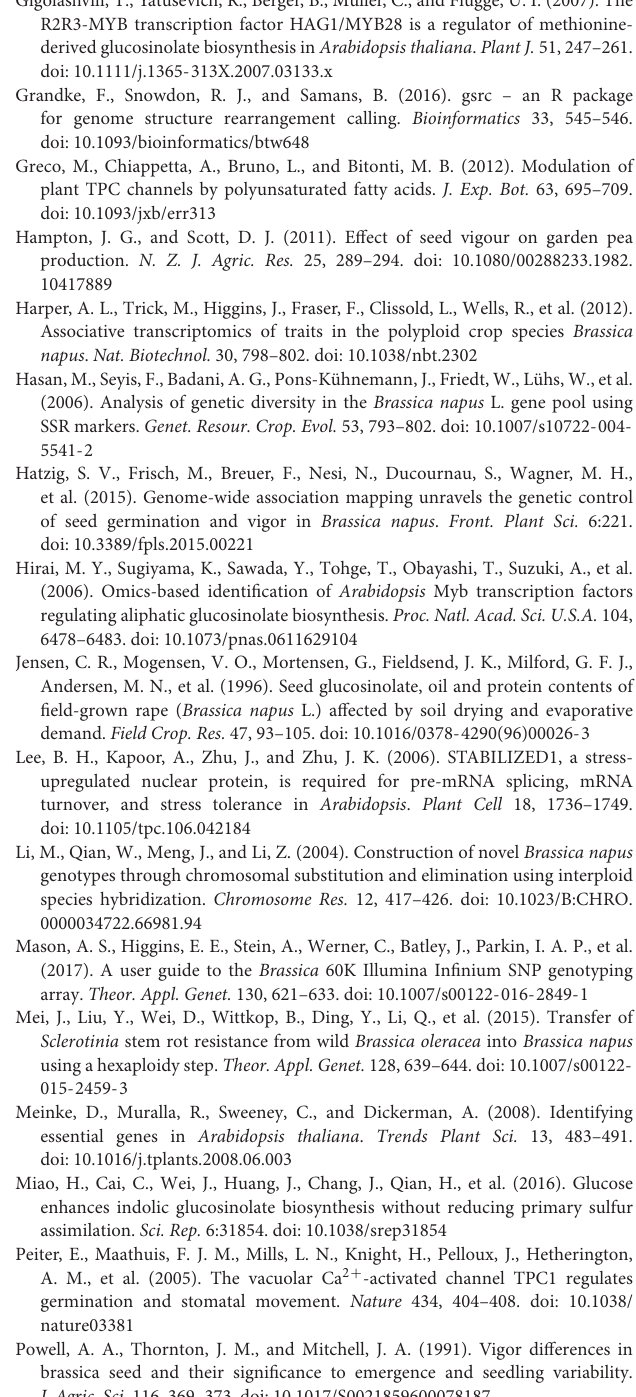
TABLE S2 | List of genes, associated with QTL marker Bn-A01-p26914512 on chromosome A9. Gene-ID, name of gene; Start: physical start position of gene in bp; Stop: physical stop position of gene in